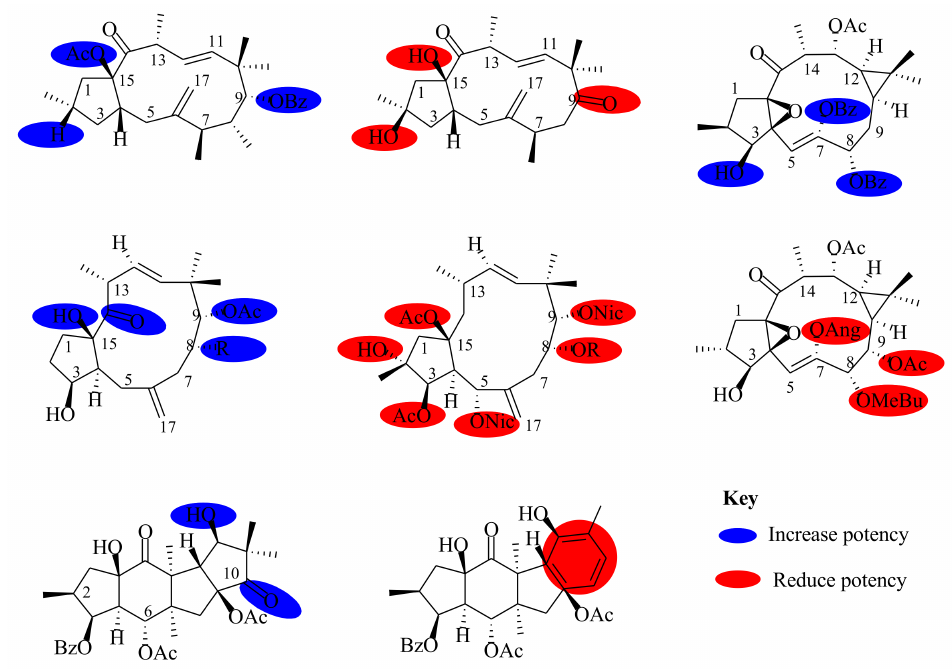
Figure 17. Key pharmacophoric elements of jatrophanes and modified jatrophanes. Previously undescribed diterpenoids isolated from E. pekinensis were evaluated for their cytotoxicity activities against human prostate cancer (C4-2B), enzalutamide-resistant C4-2B cell line (C4-2B/ENZR), and human breast cancer cells (MDA-MB-231). All